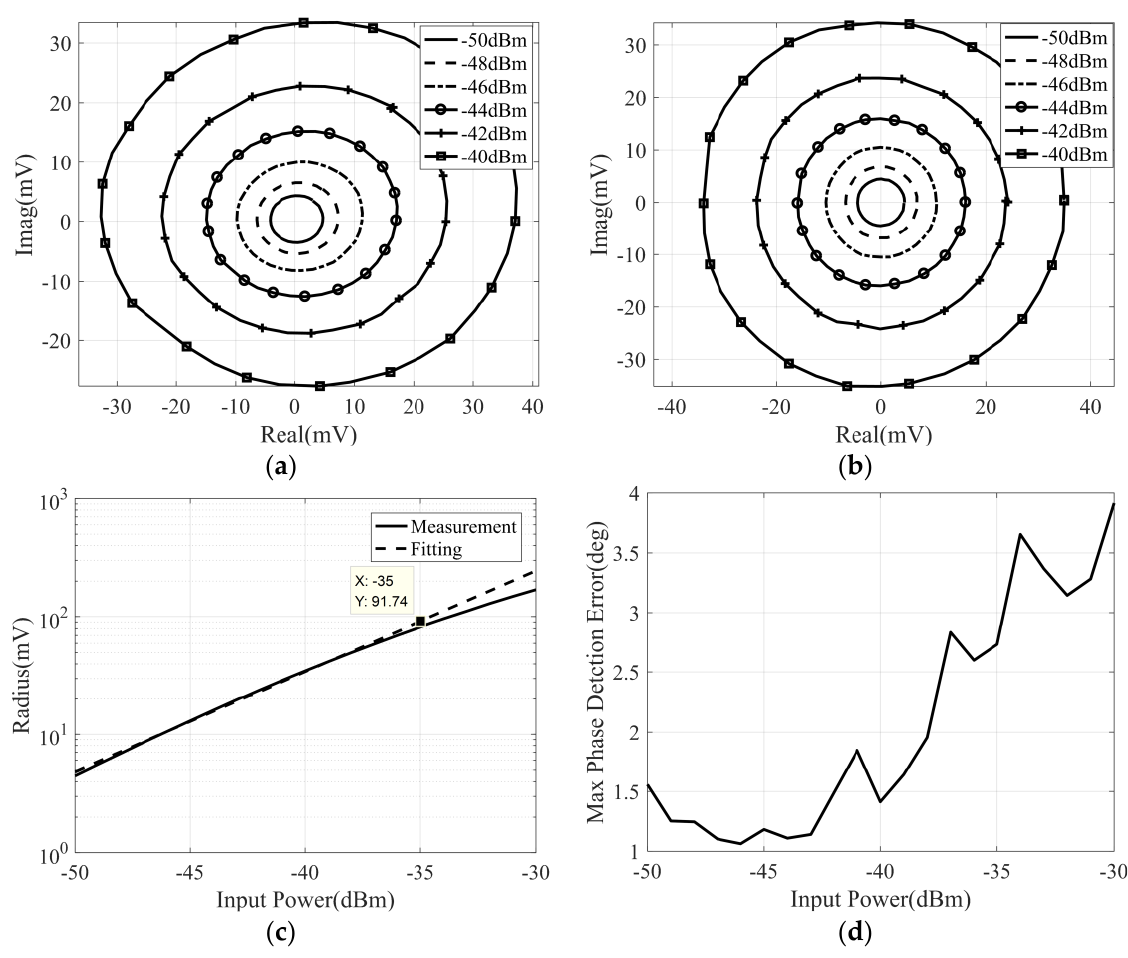
Figure 12. The measurement and calibration result of the correlator under the condition that the frequency of the input signals is 34 GHz and the power varies from − 30 dBm to − 50 dBm: ( a ) measured correlation circle; ( b ) calibrated correlation circle; ( c ) the correlation circle radius versus input power; ( d ) the variation in maximum phase detection error with input power.